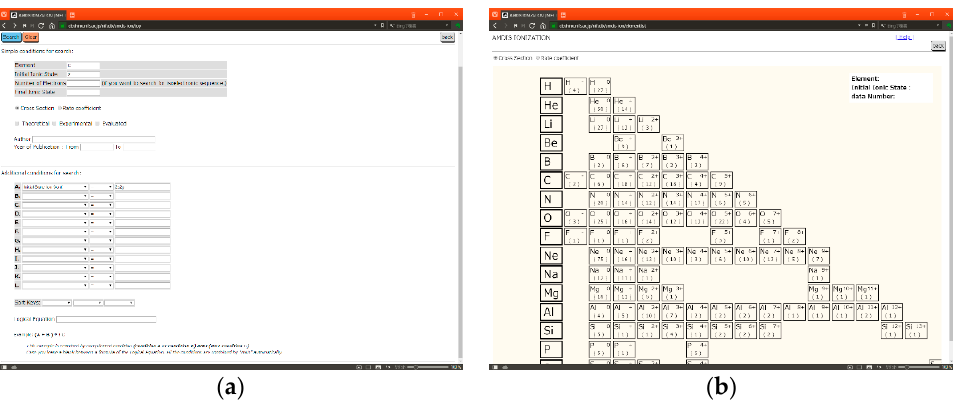
Figure 2. The graphical user interface ( GUI) of the NIFS DB. ( a ) The user can search data by constructing complex queries in the web browser. ( b ) For simplicity, the user can obtain the expected data of the atoms from the periodic table interface.